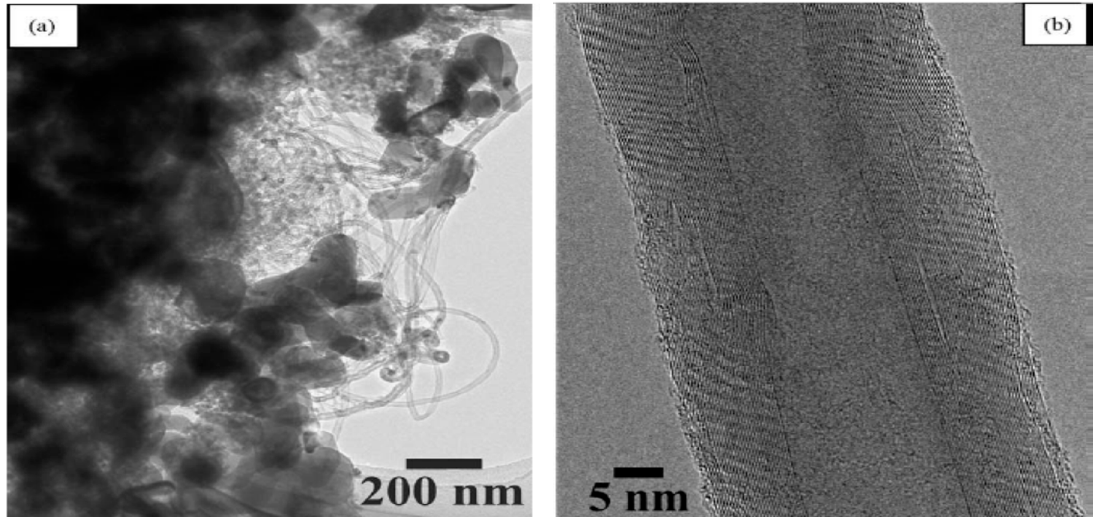
Figure 8. Transmission electron microscope (TEM) images of Al 2 O 3 -CNT nanocomposites at different resolutions ( a ) 200 nm ( b ) 5 nm. Reproduced with permission from [156]. Copyright Elsevier, 2008.